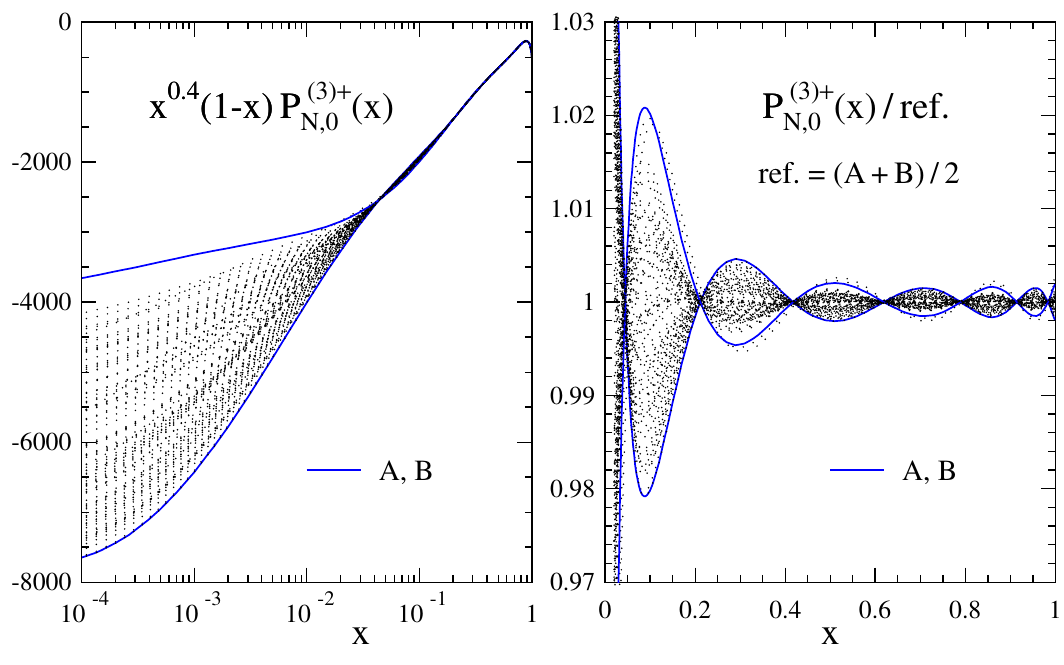
-independent contribution to the non-leading ( N ) f x ) for display purposes. The (cid:0)